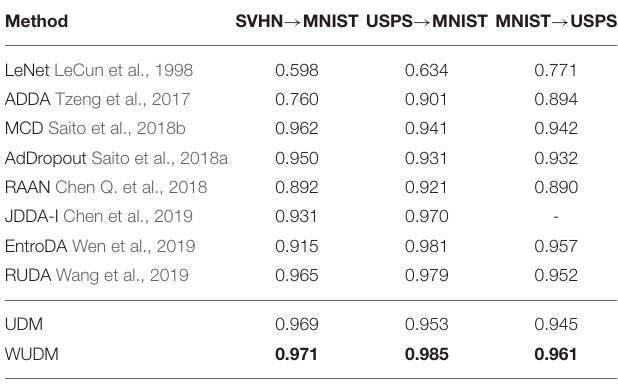
TABLE 1 | Balanced domain adaptation on the digits datasets.